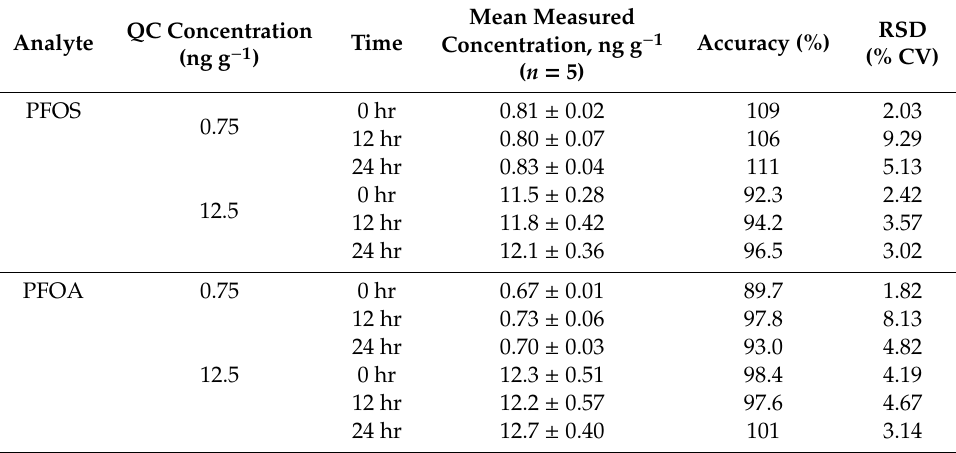
Table 2. Stability of PFOS and PFOA in egg yolk